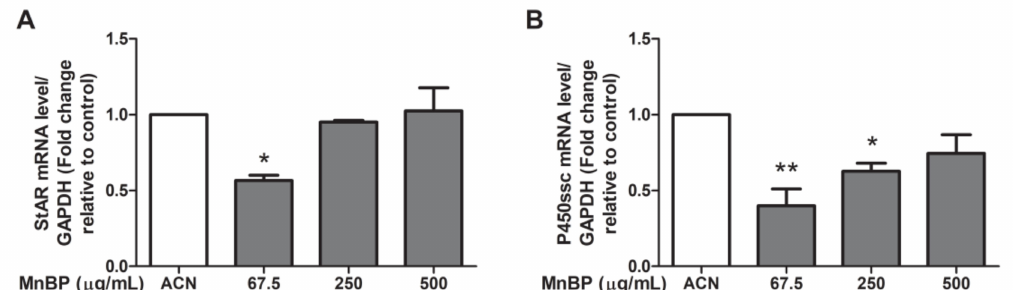
Figure 6. E ff ects of MnBP on the expression of ( A ) StAR and ( B ) P450ssc in human granulosa cells. The expression levels of mRNA for the steroidogenic acute regulatory protein (StAR) and cytochrome cholesterol side-chain cleavage enzyme (P450scc) were measured using the reverse transcription quantitative polymerase chain reaction. Human granulosa cells were seeded overnight and treated with solvent control (ACN) and 67.5, 250, or 500 µ g / mL of MnBP for 24 h. The expression levels of StAR and P450ssc were normalized to that of GAPDH. Data are shown as mean ± SD compared to those of the solvent control. * p < 0.05. ** p <